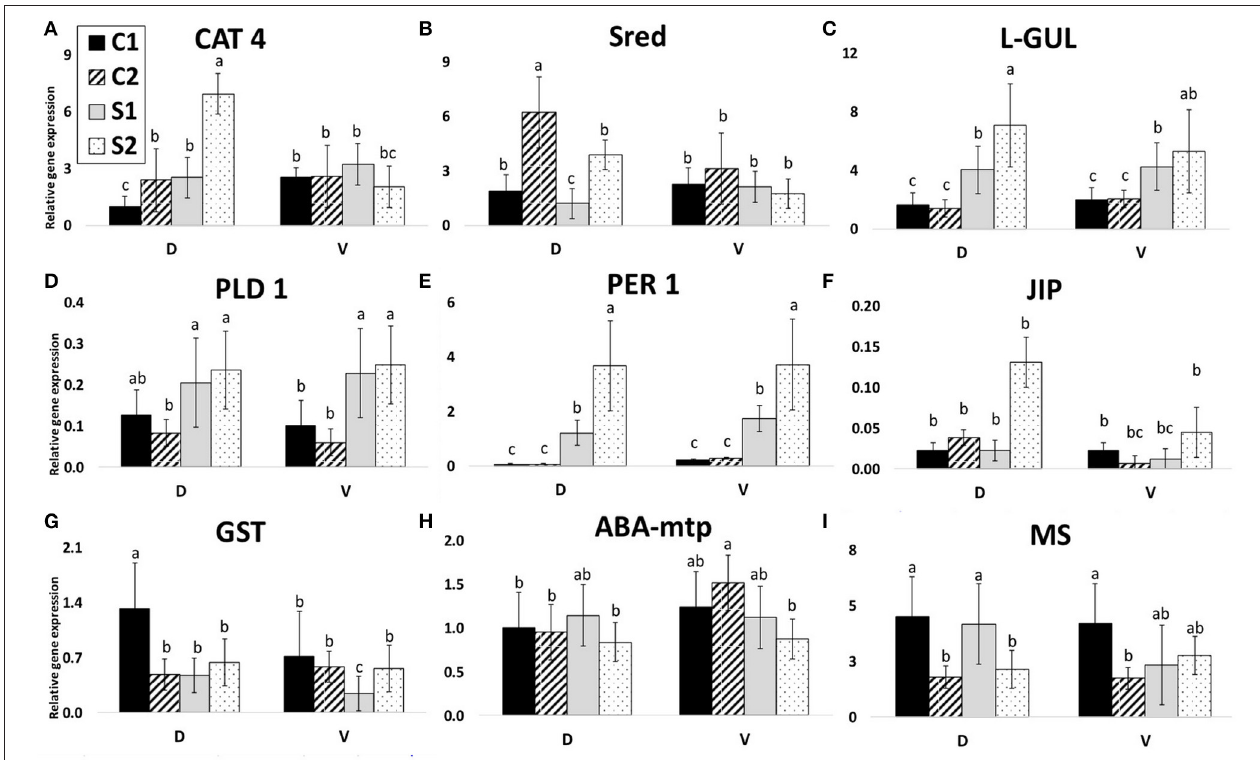
FIGURE 7 | Gene expressions. Relative gene expressions of nine selected genes according to protein identification. C1, control after 24 h after transfer to solid medium; S1, treated samples after 24 h after transfer; C2, control after 7 days after transfer; and S2, treated samples after 7 days after transfer. Gene expression was calculated according to the 2 − 11 CT method. Means with the same letter within each gene are not significantly different at 5% probability. Error bars denote three technical replications. (A) CAT 4, catalase; (B) Sred, sultite reductase; (C) L-GUL, putative lactoylglutathione lyase; (D) PLD 1, phospholipase D alpha 1; (E) PER 1, peroxiredoxin antioxidant; (F) JIP, jasmonate inducible protein; (G) GST, glutathione S-transferase; (H) ABA-mtp, ABA-modulated tyrosine-phosphorylated protein; (I) MS, 5-methyltetrahydropteroyltriglutamate-homocysteine